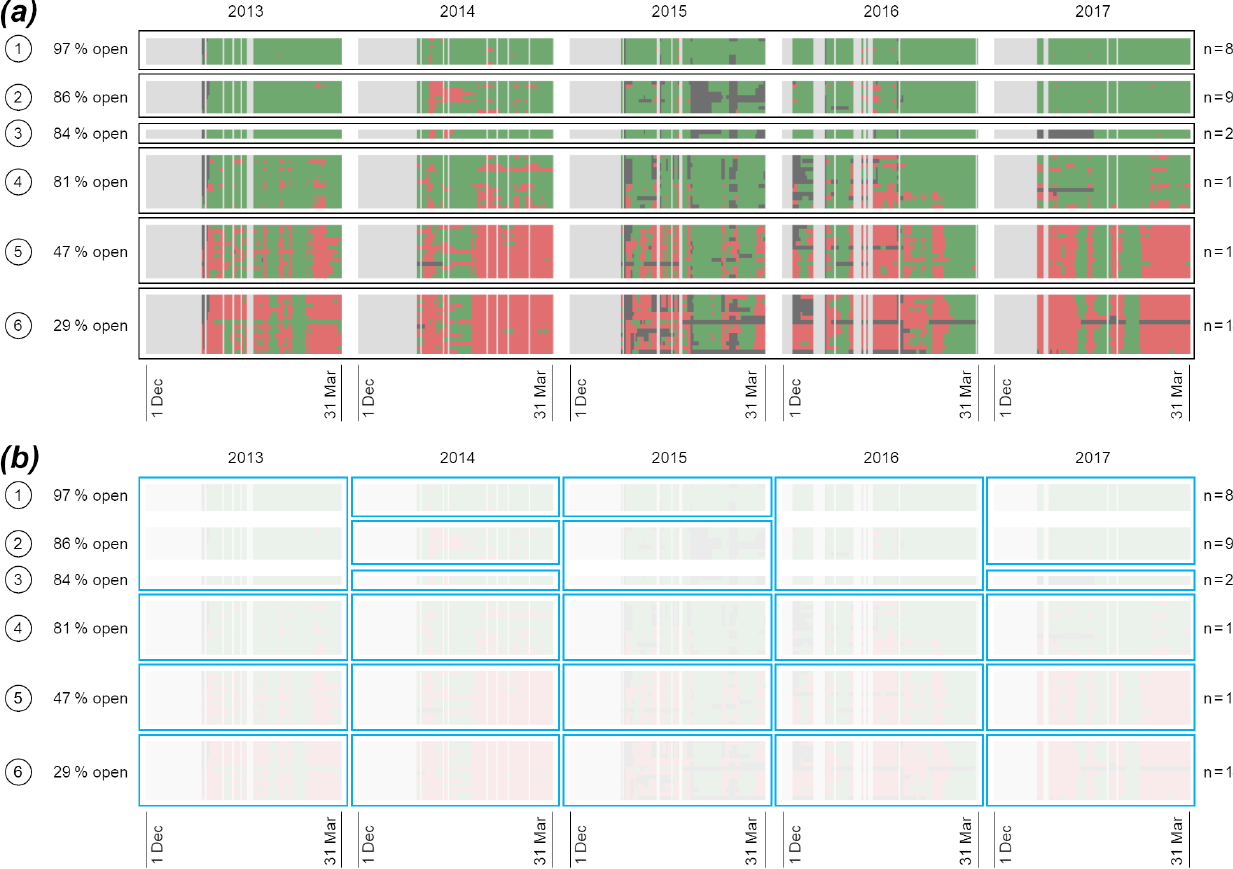
Figure 1. Identified ski run hierarchy with groups of similarly managed ski runs at NEH with (a) typical time series of run list ratings for the winter seasons from 2013 to 2017 and (b) inter-seasonal variation within the ski run hierarchy. The time series strips of each group consist of colour-coded rows representing the run list ratings of the individual runs included in that group. Taller strips therefore represent groups with larger numbers of runs. Days when ski runs were open are shown in green, days when they were closed due to avalanche hazard are shown in red and days when they were not discussed or closed due to non-avalanche-hazard-related reasons are shown in black. Days with no run list data at all (e.g., prior to operating season, days when operation was shut down due to inclement weather conditions) are shown in grey. Panel (b) shows the identified within-season clusters (blue boxes) with multi-season ski run classes